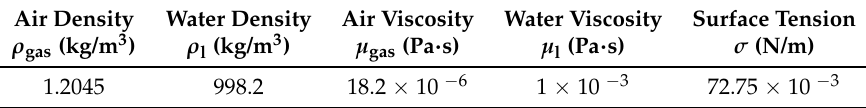
Table 1. Physical properties of the air and water drop (20 ◦ C) within the simulations.